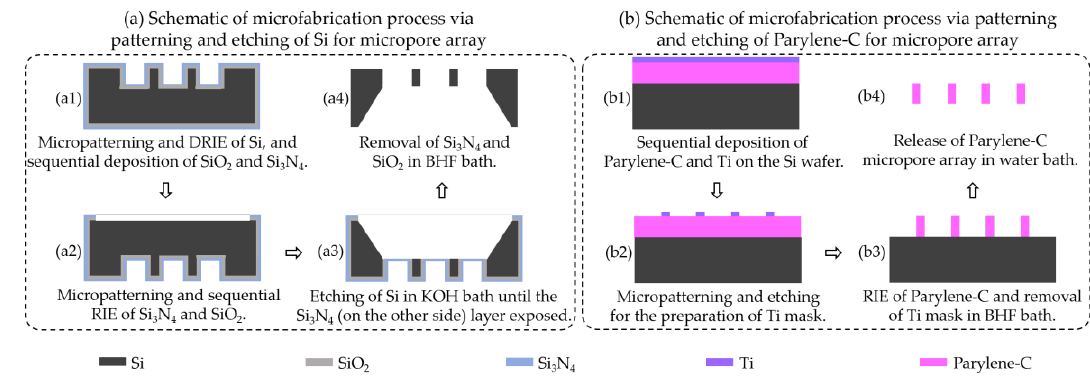
Figure 1. Schematic of microfabrication process via micropatterning and etching of Si ( a ) and Parylene-C ( b ) for micropore arrays preparation.